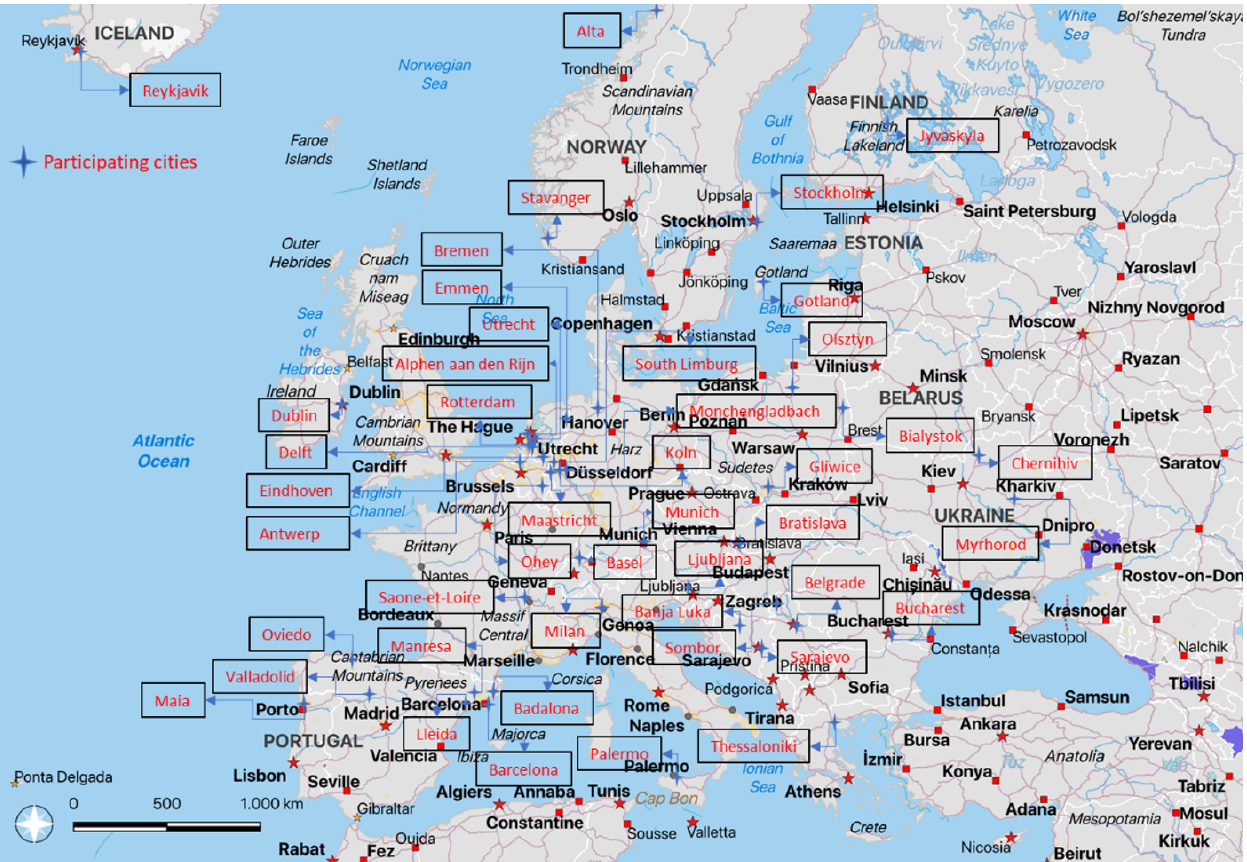
Figure 1. Location of the 42 cities or urban regions included in the survey (city name in square